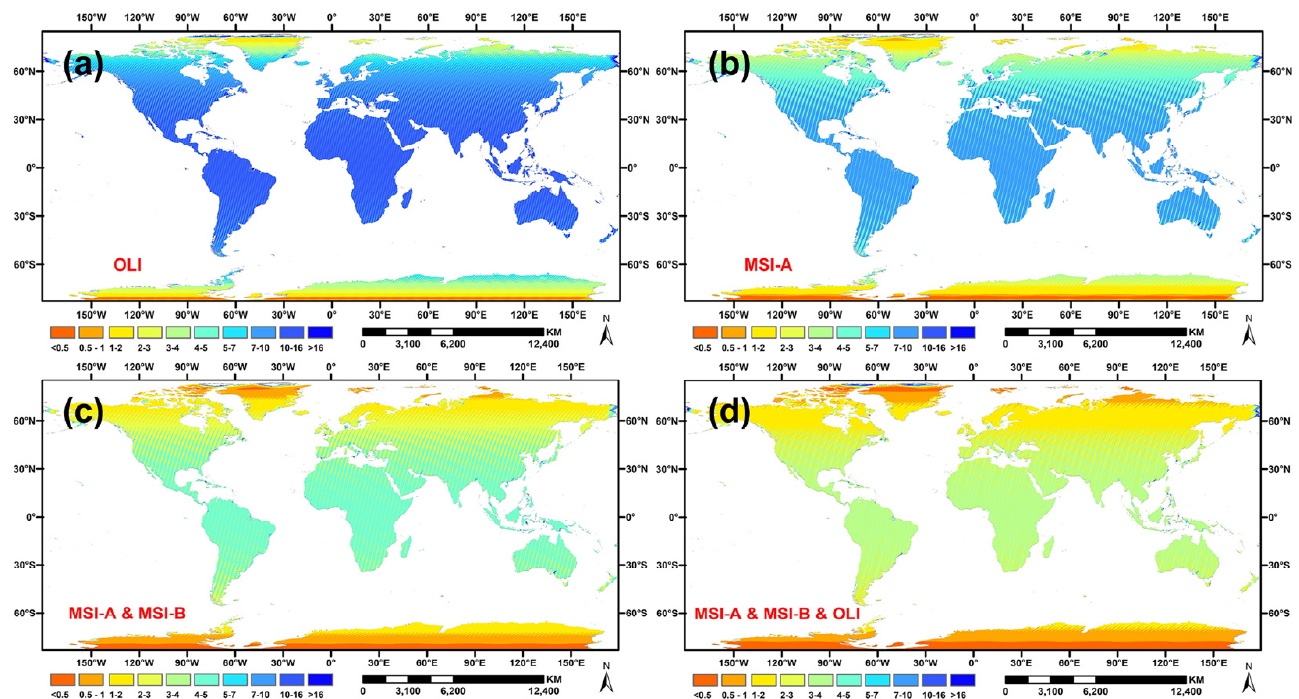
Figure 9. Percentage of mean potential revisit cycles over globe land for ( a ) Landsat-8, ( b ) Sentinel-2A, ( c ) Sentinel-2A/B and ( d ) their configurations.